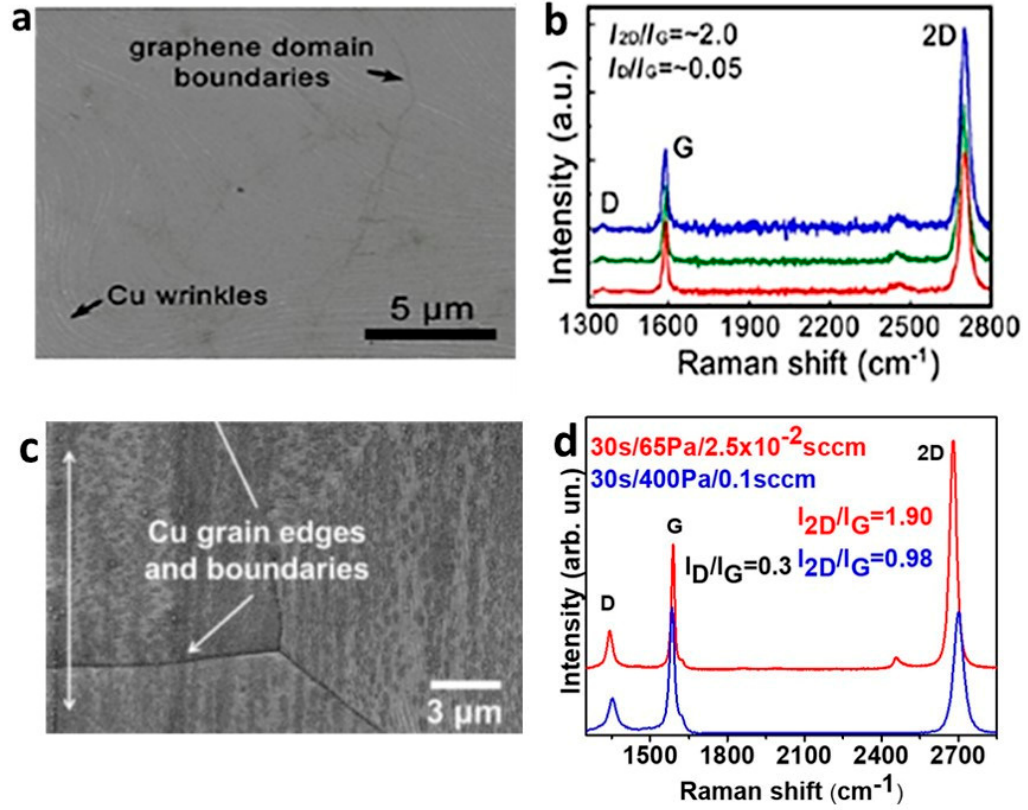
Figure 2. SEM images and Raman spectra of continuous graphene films grown by ethanol-CVD. ( a ) SEM image of graphene grown on the internal surface of the Cu enclosure at 1000 ◦ C for 10 min (10 sccm of ethanol and 300 Pa of total pressure) and ( b ) corresponding Raman spectra taken in three di ff erent positions of the same sample transferred on a SiO 2 / Si substrate. All Raman spectra are indicative of high-quality monolayer graphene and reveal the overall uniformity of the film. Adapted from [61] with permission of American Chemical Society, Copyright 2013. ( c ) SEM image of graphene grown on copper at 1070 ◦ C for 20 s (0.1 sccm of ethanol, 10 sccm of hydrogen, and 400 Pa of total pressure). Adapted from [38] with permission from Elsevier, Copyright 2014. ( d ) Raman spectra of graphene, transferred on a SiO 2 / Si substrate, grown in di ff erent conditions (red curve: 30 s for growth time, 65 Pa for total pressure, 2.5 × 10 − 2 sccm for ethanol flow rate; blue curve: 30 s for growth time, 400 Pa for total pressure, 0.1 sccm for ethanol flow rate). Original data from our group (unpublished).